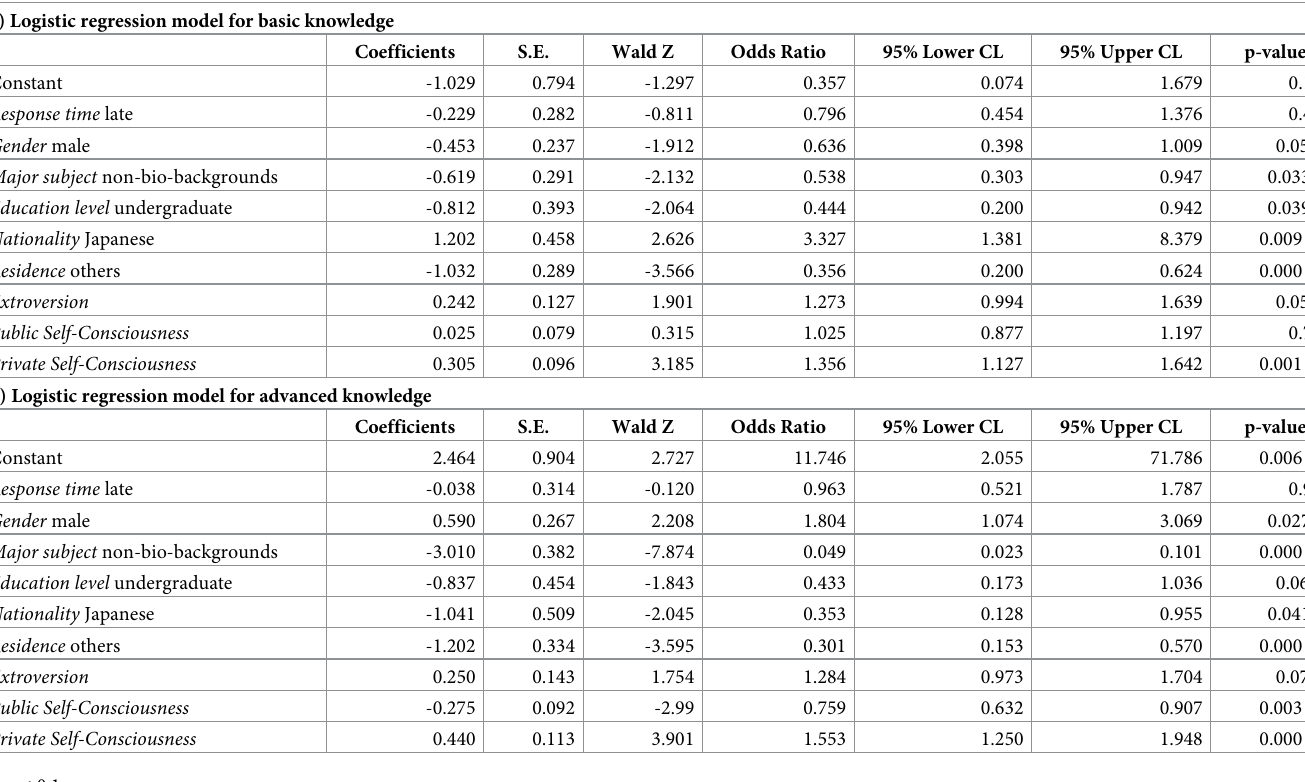
Table 2. Logistic regression models for university students’ knowledge levels. a) Logistic regression model for basic